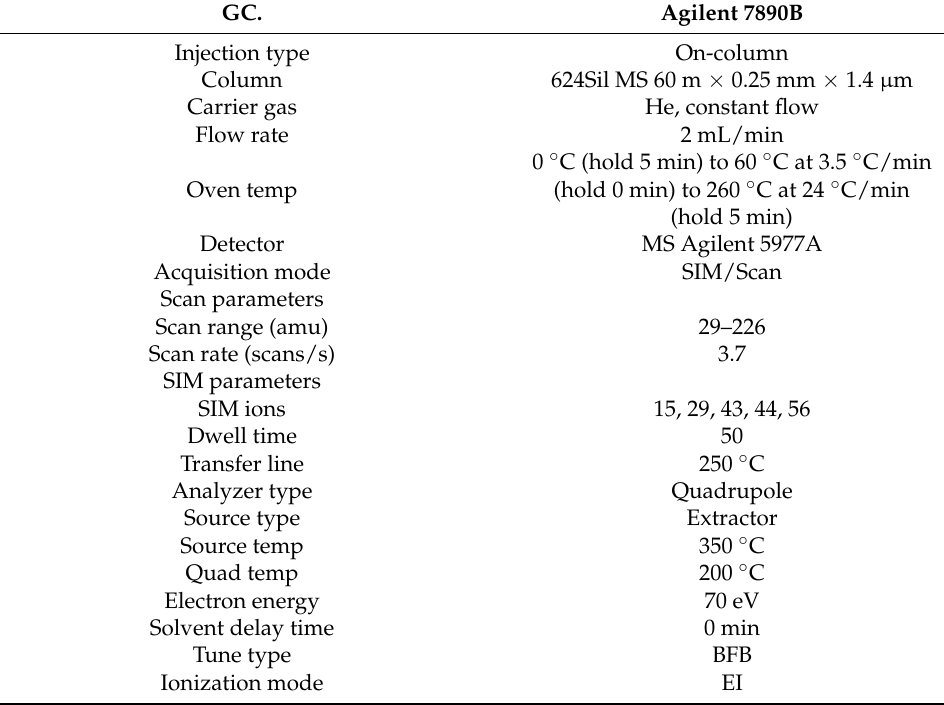
Table 3. Gas chromatography-Mass Spectrometry (GC-MS) parameters.